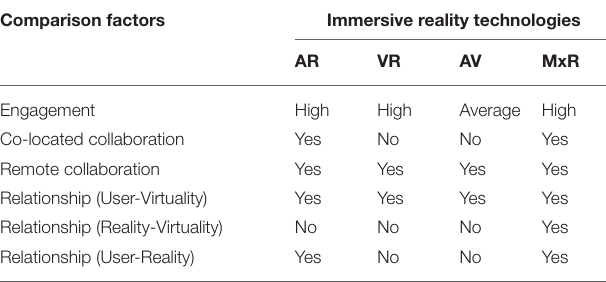
TABLE 1 | Comparison of immersive reality technologies (summary of Table 3 ). Comparison